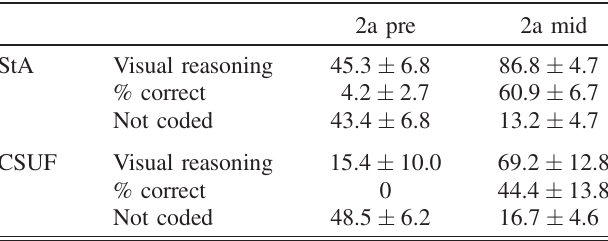
TABLE III. The percentage of pre- and midtest responses to question 2a that were coded as visual, and the percentage of correct reasoning of these